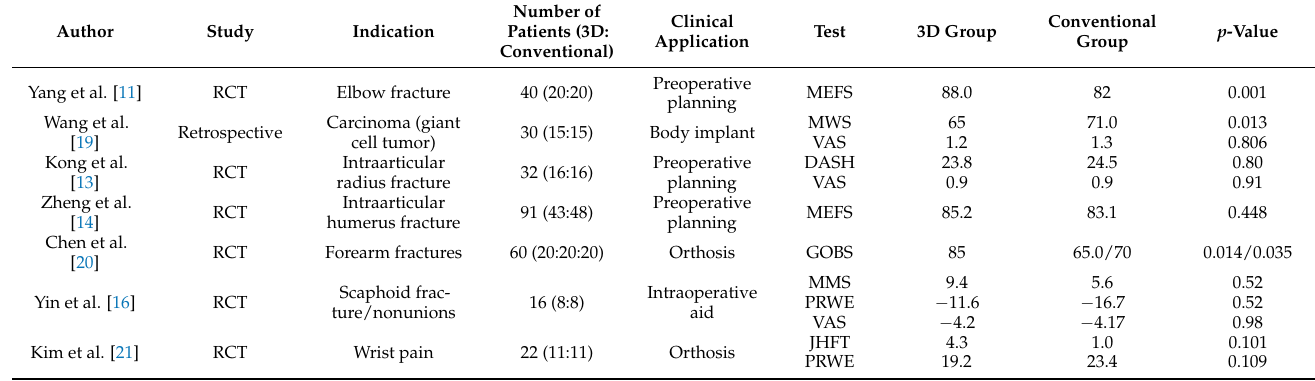
Table 2. Functional outcome of included comparative clinical studies; 3D = three-dimensional; RCT = randomized controlled trial; MEFS = Mayo Elbow Function Score; MWS = Mayo Wrist Score; VAS = Visual Analogue Scale; DASH = disability of the arm, shoulder, and hand; MMS = Modified Mayo Score; GOBS = Green and O’Brien Score; JHFT = Jebsen Hand Function Test; PRWE = Patient- Rated Wrist